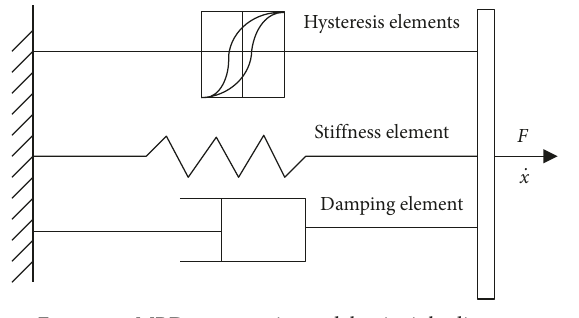
Figure 5: MRD parametric model principle diagram.